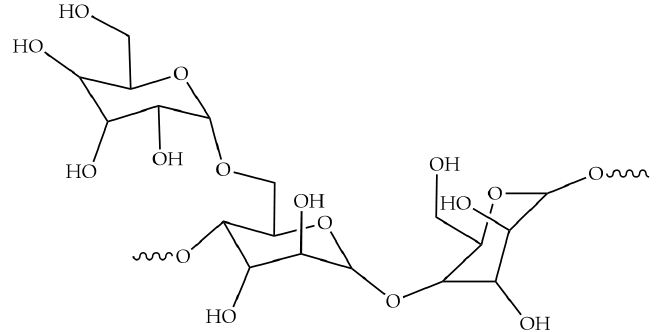
Figure 6. The structure of Guar gum